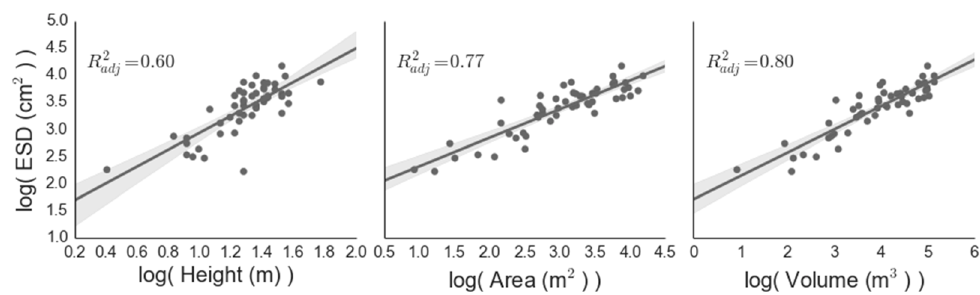
Figure 7. Ground-derived relationships between canopy parameters and equivalent stem diameter (ESD; see Equation (1)). Both axes have been log transformed to establish linear fits.